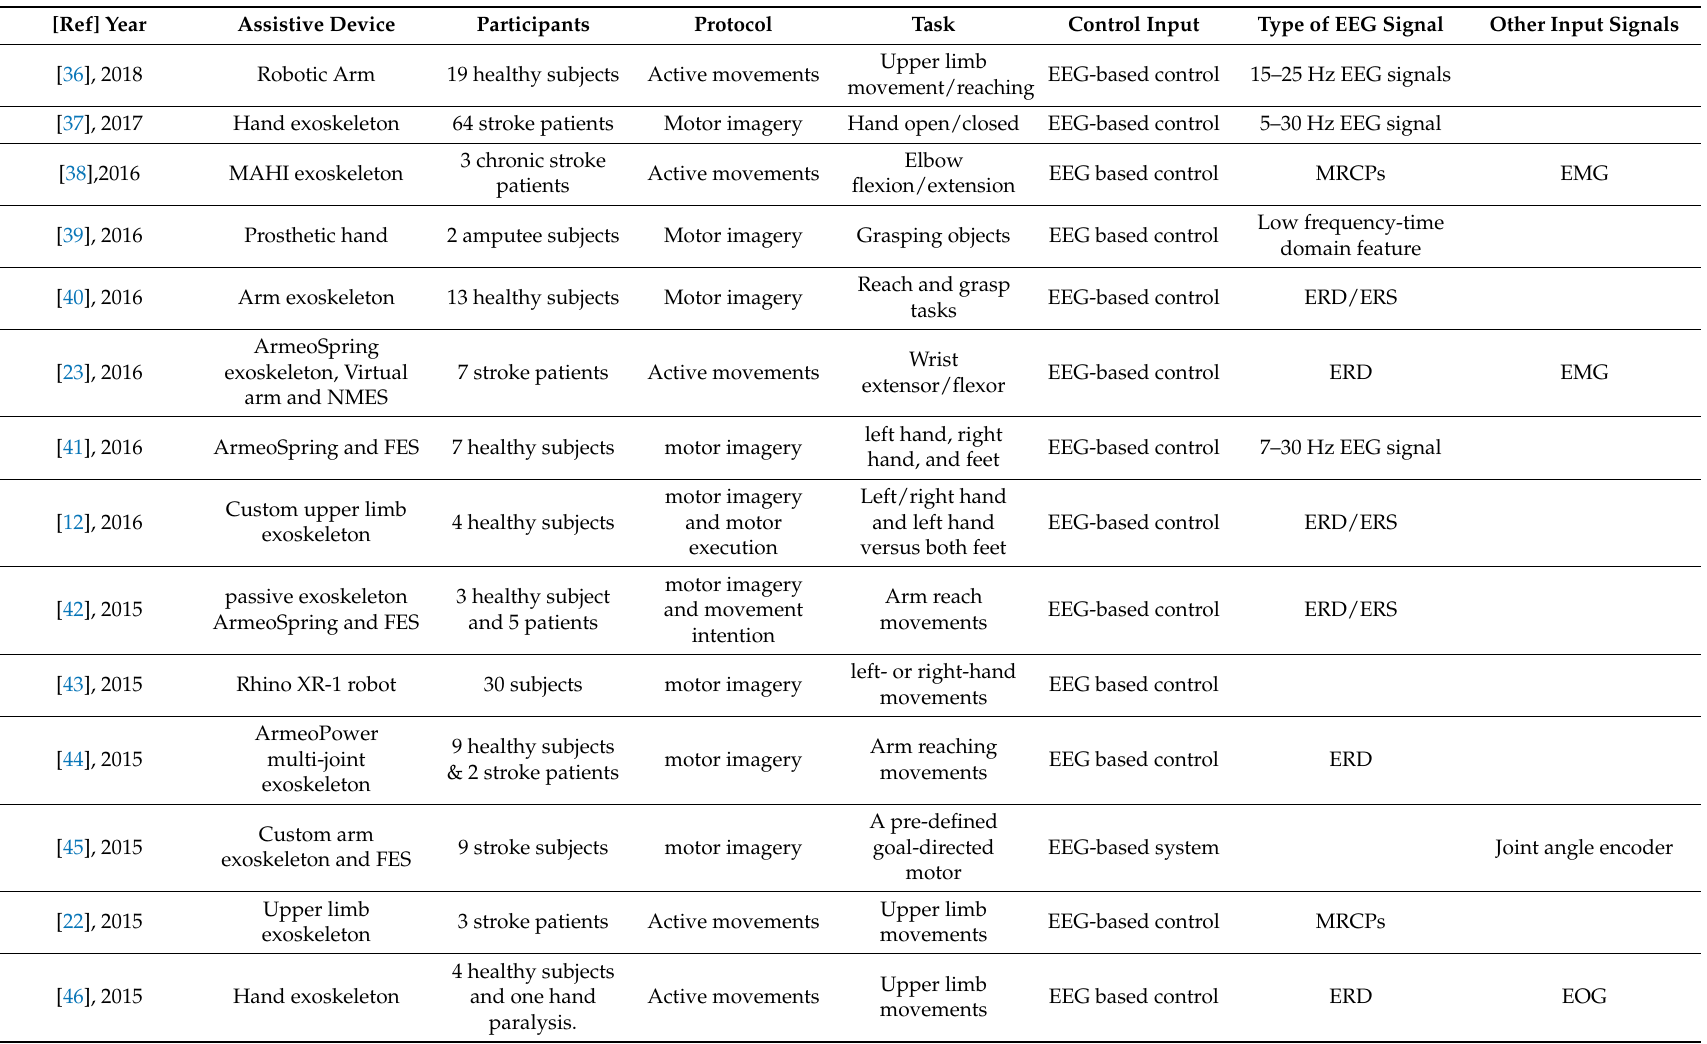
Table 3. EEG based control for upper limb